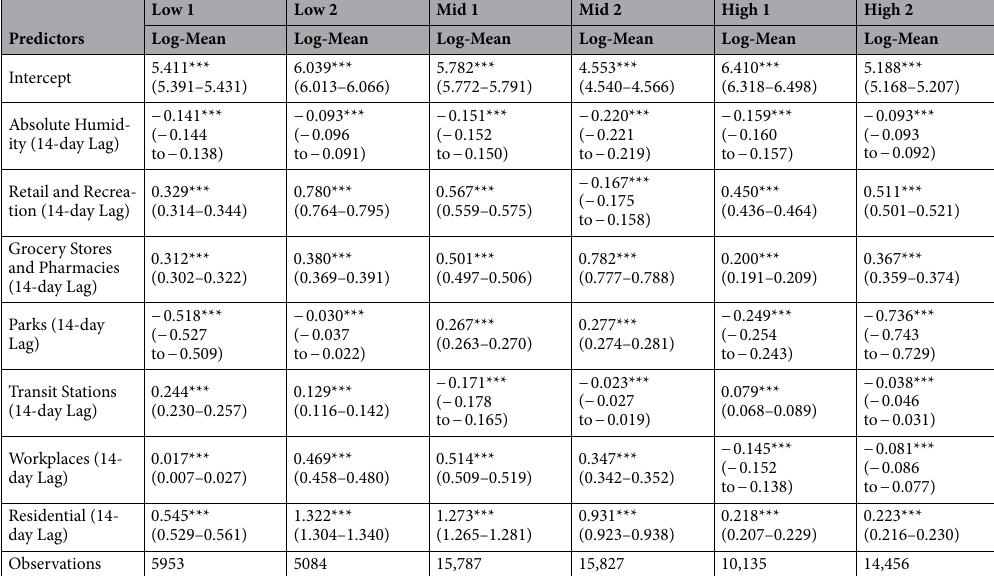
Table 3. Untransformed GLM coefficient estimates for the 2020 winter and 2021 spring seasons. Untransformed coefficient ( β ) estimates for GLM Regression against new cases per 100,000 from October 1, 2020 to March 1, 2021. The 95% confidence intervals are shown in parenthesis. Estimated coefficients for county-level fixed effects and epidemiological terms (immunity factor and lagged daily cases) are not shown. * p < 0.05 ** p < 0.01 *** p <